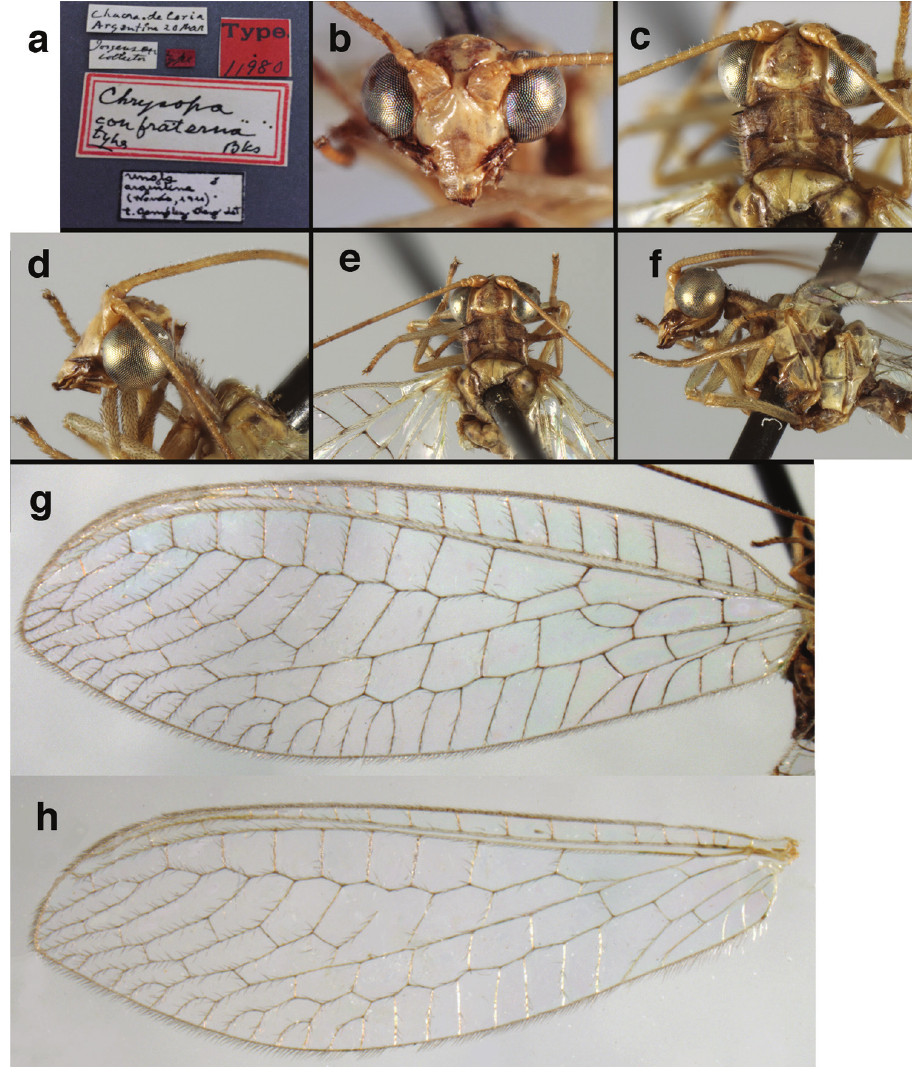
Figure 120. Chrysopa confraterna Banks: External features, ( a ) labels ( b ) head, frontal ( c ) head, pro- thorax, mesothorax (partial), dorsal ( d ) head, lateral ( e ) head, thorax, dorsal ( f ) head, thorax, lateral ( g ) forewing ( h ) hindwing (Argentina, Mendoza, Chacras de Coria, holotype, male,